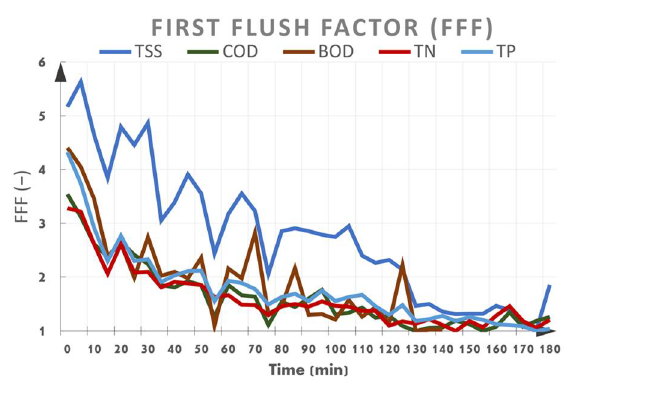
Table 3. Characteristics of first flush and spread factors for first 1.5 h of overflow event. TSS COD BOD TN TP FIRST FLUSH FACTOR VERY HIGH